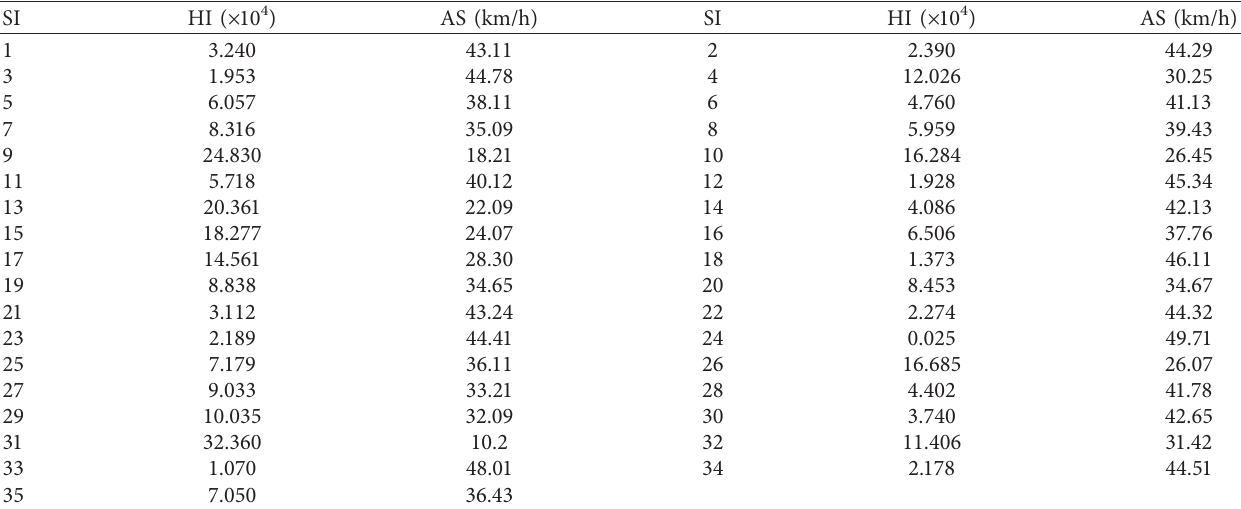
Table 1: The results of the simulation test.